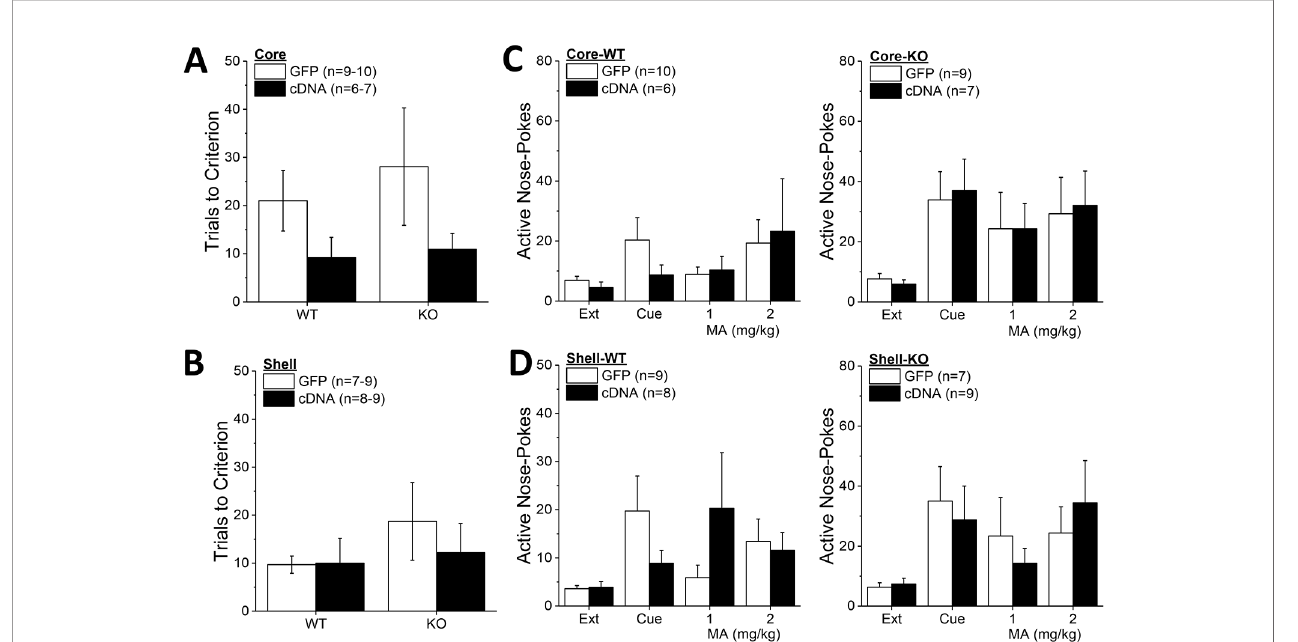
FIGURE 8 | Homer2b overexpression in nucleus accumbens (NAC) subregions does not signi fi cantly alter genotypic differences in responding under extinction- reinstatement procedures. Although it appeared that cDNA infusion into the NAC core reduced the number of trials taken to reach extinction criterion in both wild- type (WT) and Homer2 knockout (KO) mice, no cDNA effect was observed on this measure when infused into either the NAC core (A) or the NAC shell (B) . (C) Homer2 KO mice exhibited greater cue- and MA-primed reinstatement of active hole responding than WT mice, but NAC core infusion of cDNA did not affect responding in either WT (0left) or KO animals (right). (D) cDNA infusion into the NAC shell also did not alter the genotypic difference in reinstatement. The data represent the means ± SEMs of the number of mice indicated in their respective panels. Main Genotype effects are not indicated for clarity but are described in the text. The sample sizes in this fi gure are lower than those indicated in Figures 6 and 7 as some animals were euthanized following MA self-administration procedures due to